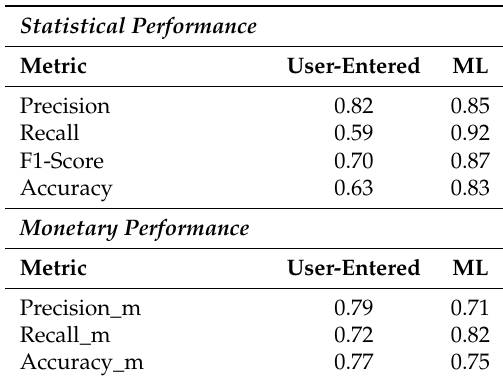
Figure 10. Validation Set Results: ( a ) Statistical and ( b ) Monetary performance of user-entered and ML predictions. Refer to Figure 9 caption for further explanations. Table 6. Validation Set Performance